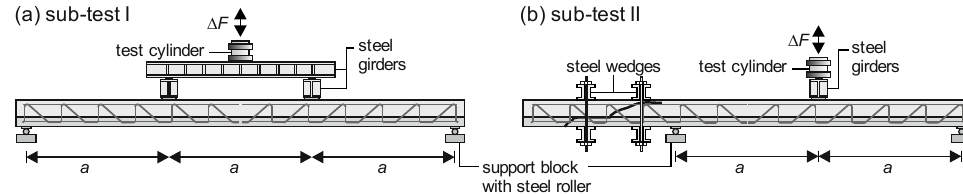
Figure 10. Assessed S–N curve for lattice girders in the latest technical approvals [41,42].